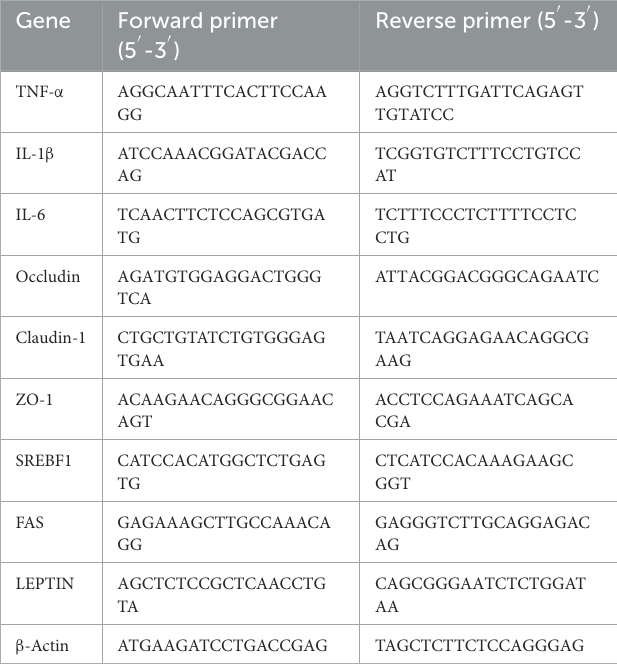
TABLE 1 The primer sequences for quantitative (qPCR) analysis of intestinal inflammation, tight junction proteins, and lipid metabolism-related genes. Gene Forward